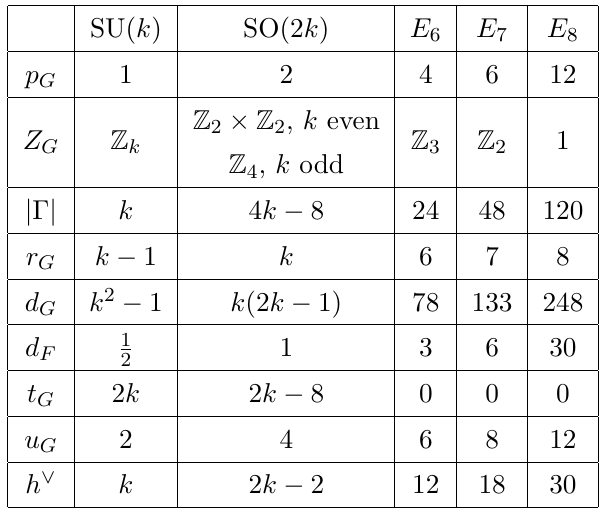
Table 1 . Various data used in this paper. Here Z G , r G , and d G are the center, rank and dimension of the group G respectively. j (cid:0) j is the order of the (cid:12)nite group (cid:0). d F and h _ are the Dynkin index of the fundamental representation and the dual Coxeter number of the group G . p G ; t G and u G are various group dependent